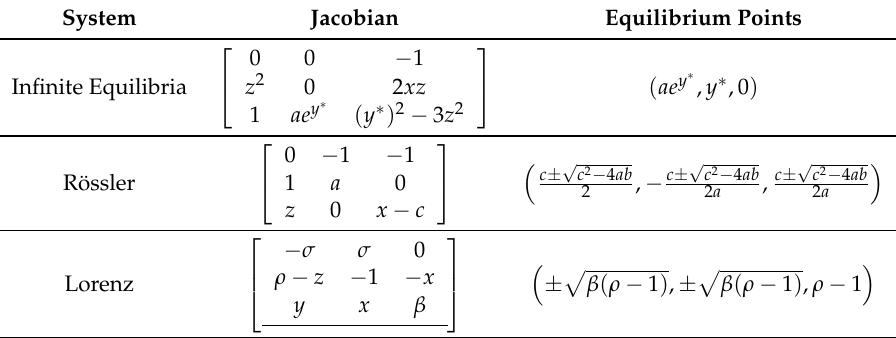
Table 2. Jacobian and equilibrium points of the chaotic systems given in Equations (1)–(3). System Jacobian Equilibrium Points Infinite Equilibria